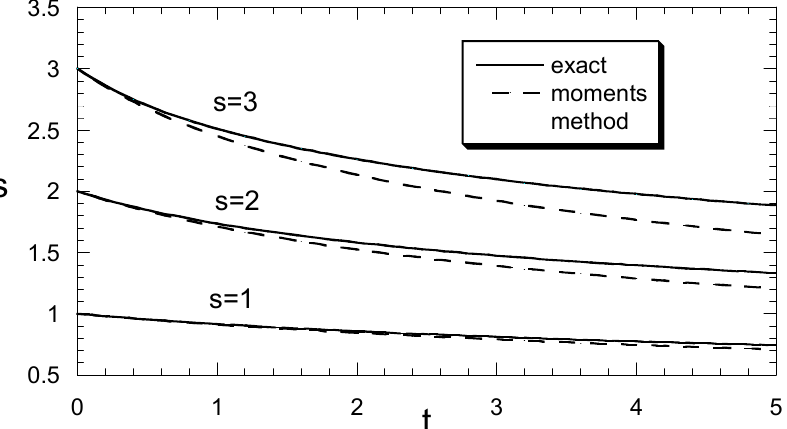
Figure 2. Exact and computed results with the method of moments dispersities versus dimensionless time for three values of the initial dispersity s o .